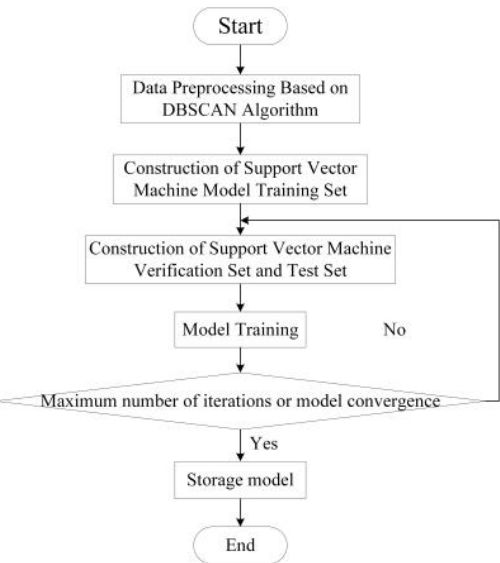
ffl ine support vector machine (SVM) model Figure 2. Flowchart for offline support vector machine (SVM) model training. Figure 2. Flowchart for o